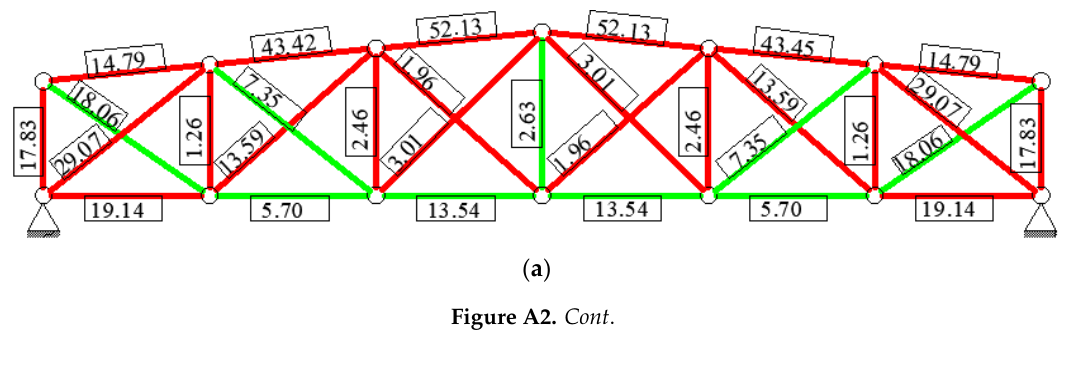
Figure A1. Cross-sectional forces of truss “A” in the passing minutes of a fire: ( a ) t fi = 0 min; ( b ) t fi = 20 min; ( c ) t fi = 20.05 min (1203 s); ( d ) t fi = 20.07 min (1204 s); ( e ) t fi = 25 min; and ( f ) t fi = 29.2 min (1752 s).